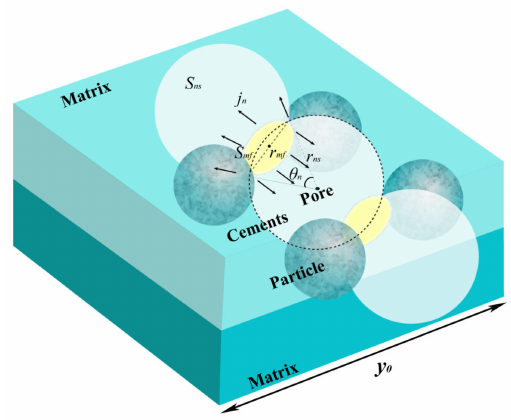
Figure 2. Schematic of the matrix and kerogen